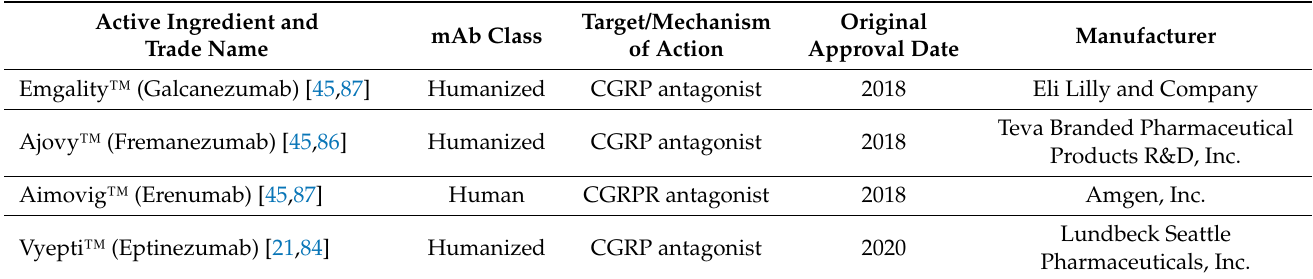
Table 7. Monoclonal antibodies for migraine approved by the Food and Drug Administration from 2015 to